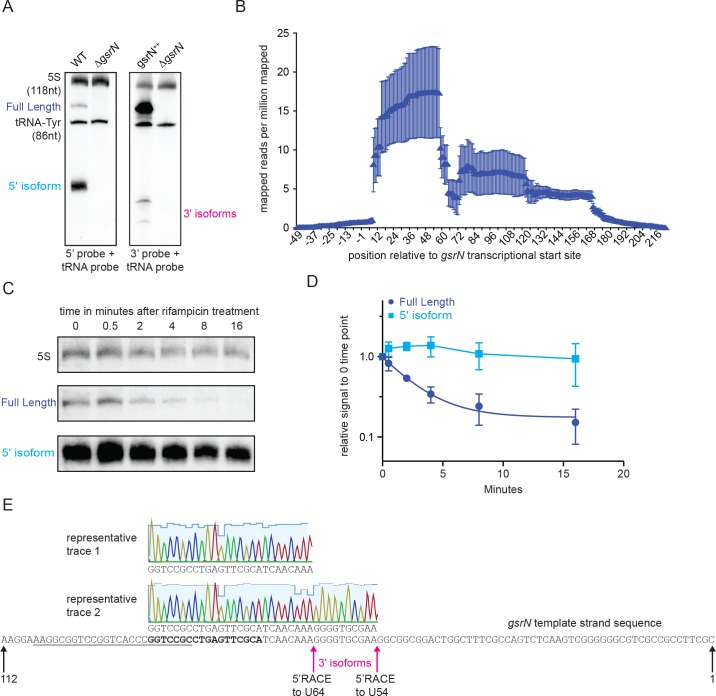
The 5’ isoform of GsrN arises from endonucleolytic processing and is the most abundant form of GsrN.(A) Northern blots of total RNA from cultures (OD660 ≈ 1.0, a condition in which GsrN levels were observed to be the highest) of wild type, ΔgsrN, and gsrN++. Blots were probed with 32P-labeled oligonucleotides complementary to either the 5’ or 3’ end of GsrN. Probes to 5S rRNA and tRNA-Tyr were used to estimate the size of full-length GsrN and its 5’ and 3’ isoforms. (B) RNA-seq read density from total wild-type RNA mapped to the gsrN locus. Chromosome position (x-axis) is marked in reference to the annotated transcriptional start site (TSS) of gsrN (position 3,830,130 in GenBank accession CP001340). Reads per million reads mapped is plotted as a function of nucleotide position. Mean ±SD from three independent biological replicates samples is plotted (GEO: GSR106168, read files: GSM2830946, GSM2830947, and GSM2830948). (C) Northern blot of total RNA extracted from wild type Caulobacter cells in exponential phase (OD660 ≈ 0.2–0.25) 0 to 16 min after treatment with 10 μg/mL rifampicin (final concentration). Bands for full-length GsrN, 5’ GsrN isoform, and 5S RNA loading control are shown. (D) Quantification of blots from (C) of full-length GsrN and 5’ GsrN isoform normalized to 5S rRNA levels in each lane. Signal at each time point is normalized relative to the zero minute time point. Data represent mean ±SD from three independent biological replicates. (E) Sanger sequencing of cloned 5’RACE (Rapid amplification of cDNA ends) products amplified from total RNA from gsrN++ cultures grown into stationary phase. Chromatographic traces 1 and 2 represent sequences of clones obtained with and without TAP treatment. The gsrN template strand sequence is shown., The underlined sequence denotes the primer used for 1 strand cDNA synthesis and the bold sequence denotes the nested primer used for 2nd strand PCR amplification. The 2nd strand amplification PCR primer was also used for primer extension in Figure 3. Chromatographic traces are colored by nucleotide with the height of the signal proportional to an intensity score (visualized in Geneious 11.0.2 scale set to 40) and the light blue background indicates the quality score. Positions of the gsrN termini are indicated with black arrows. Positions of the pink arrows correspond to the 5’end of the 3’isoforms observed in Figure 3—figure supplement 1A.